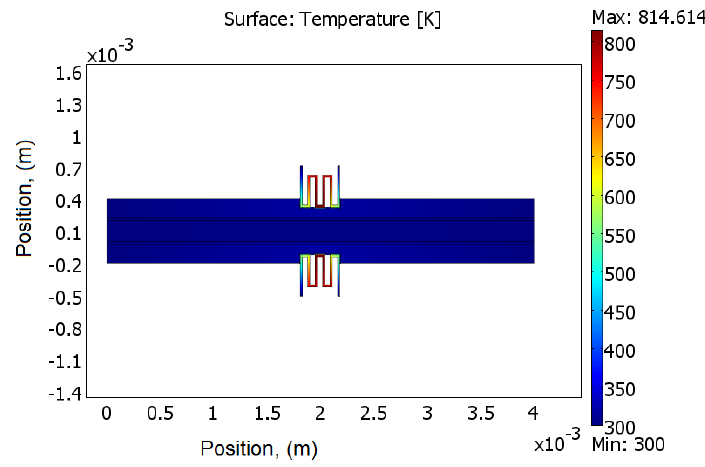
Figure 3. Simulated temperature distribution in the device.